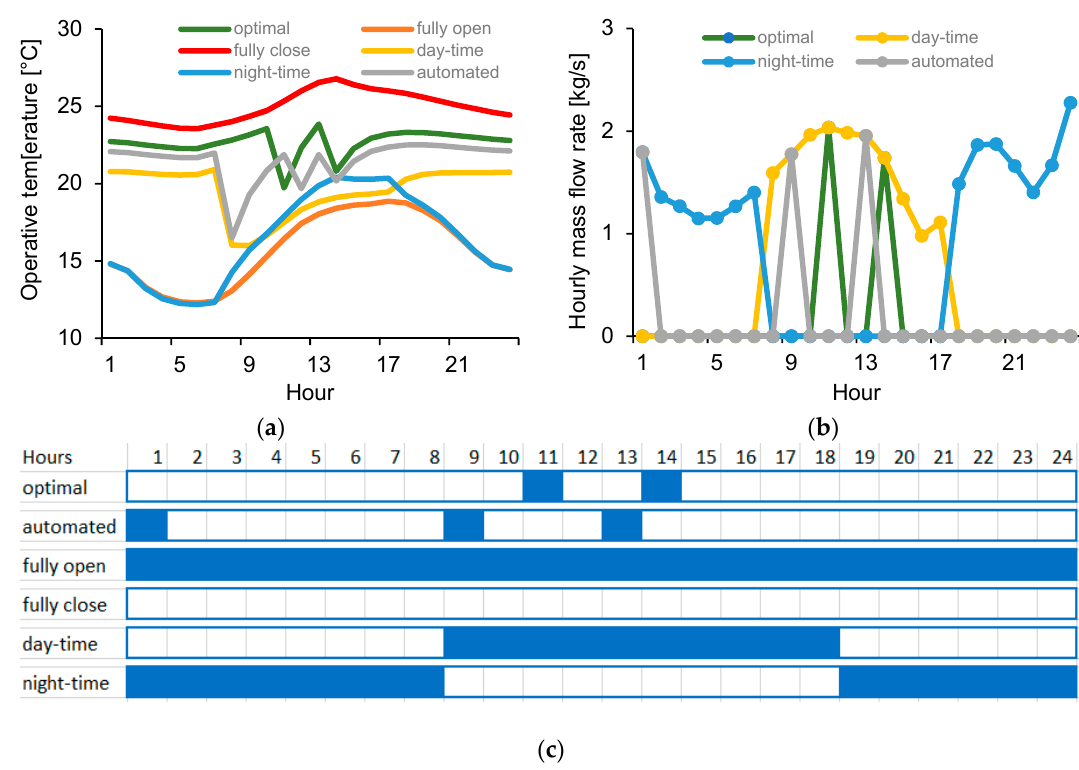
Figure 3. ( a ) Indoor operative temperature of each opening scenario; ( b ) mass flow rate of 4 different opening scenario; ( c ) Hourly opening schedules (shaded-open, unshaded-close) for all